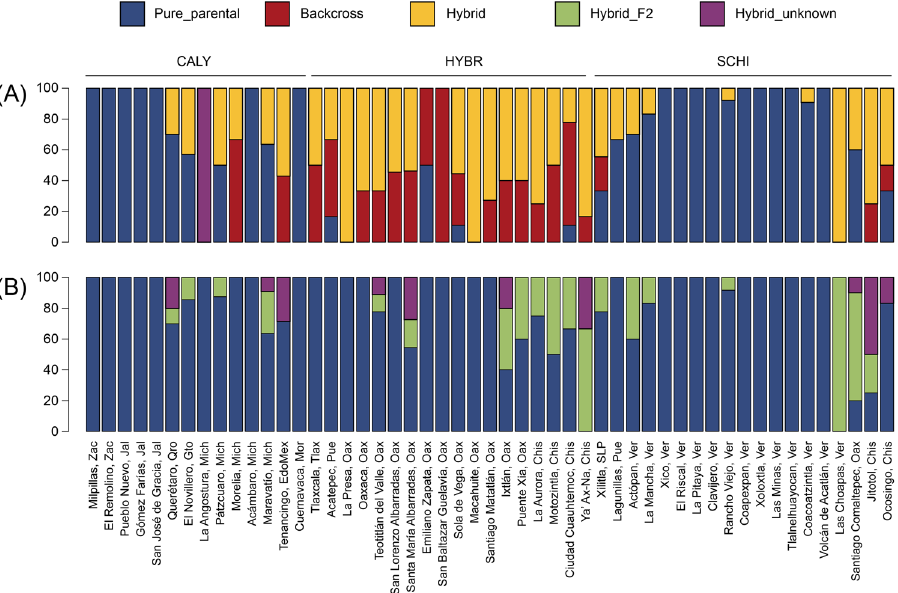
Figure 3. Percentage of hybrids in each population estimated with ( A ) STRUCTURE and ( B ) NEWHYBRIDS. CALY = calyculatus group, SCHI = schiedeanus group, OAX = Oaxaca region, CHIS = Chiapas region.